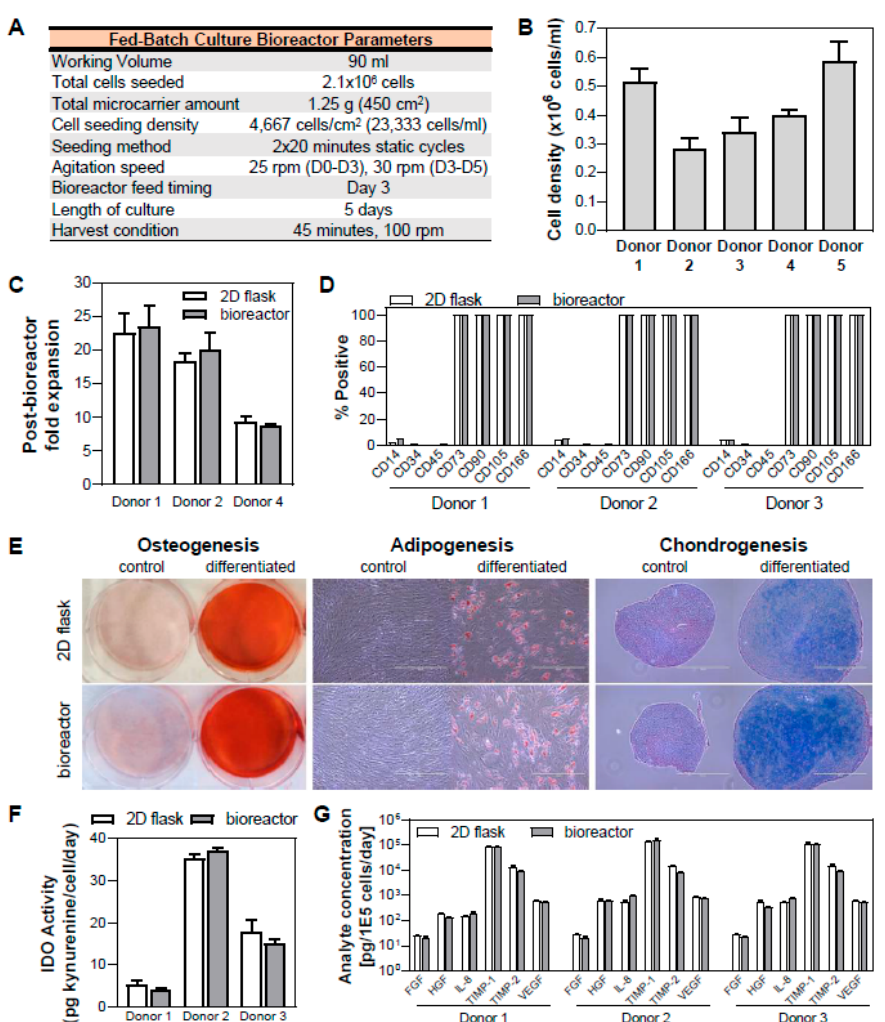
Figure 7. Validation of optimized fed-batch bioreactor process and hMSC characterization